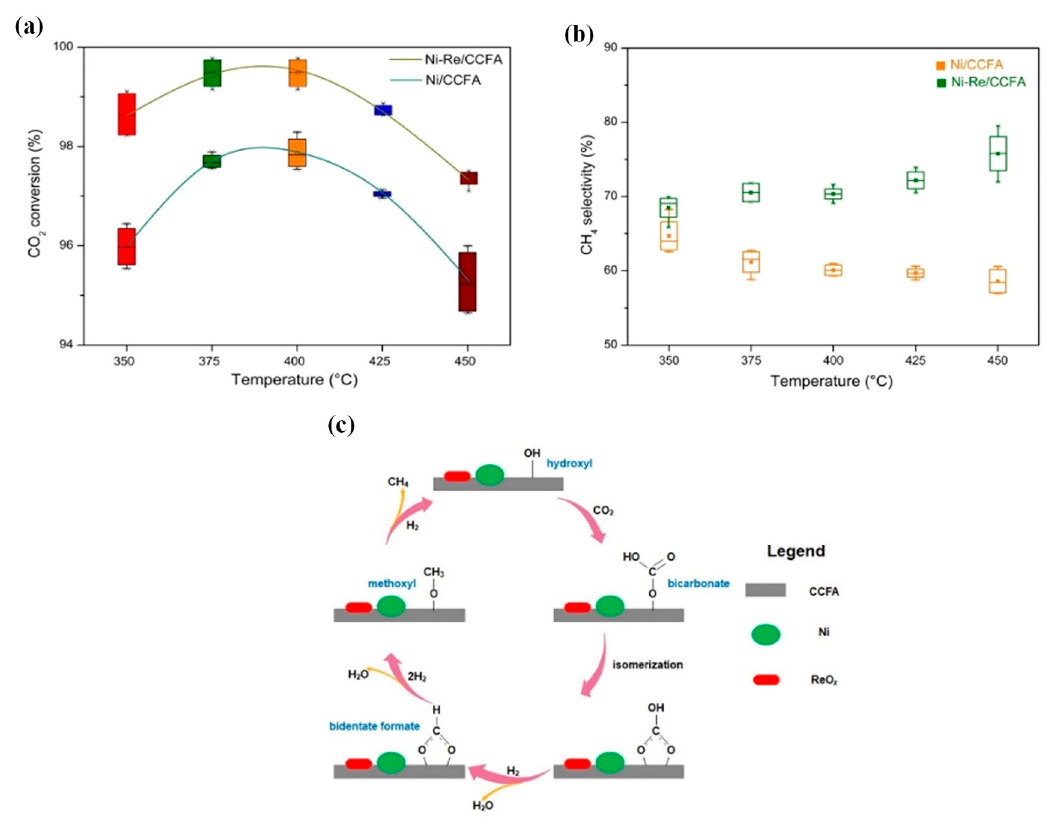
Figure 16. The effect of reaction temperature ( a , b ) on the CO 2 conversion and CH 4 selectivity. The conditions of reaction temperature test are H 2 :CO 2 :N 2 = 4:1:0.5, GHSV = 2000 h − 1 and 1 atm. ( c ) Proposed reaction mechanism of CO 2 adsorption and methanation over reduced Ni-Re/CCFA. Reproduced with permission from [130]. Copyright: Elsevier, Amsterdam, The Netherlands, 2020.